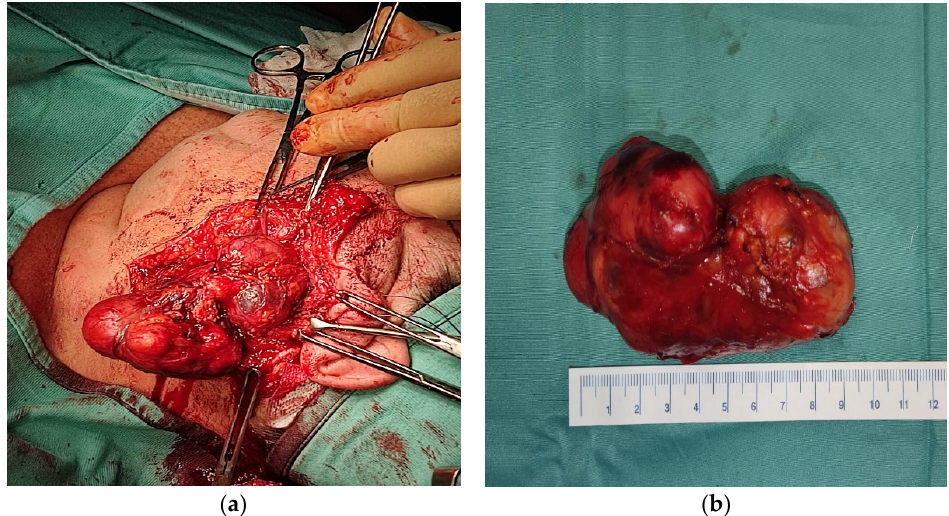
Figure 2. ( a ) Surgical field with the capsule of the tumor exposed and facial nerve preserved; ( b ) 10 cm parotid mass excised with intact capsule.